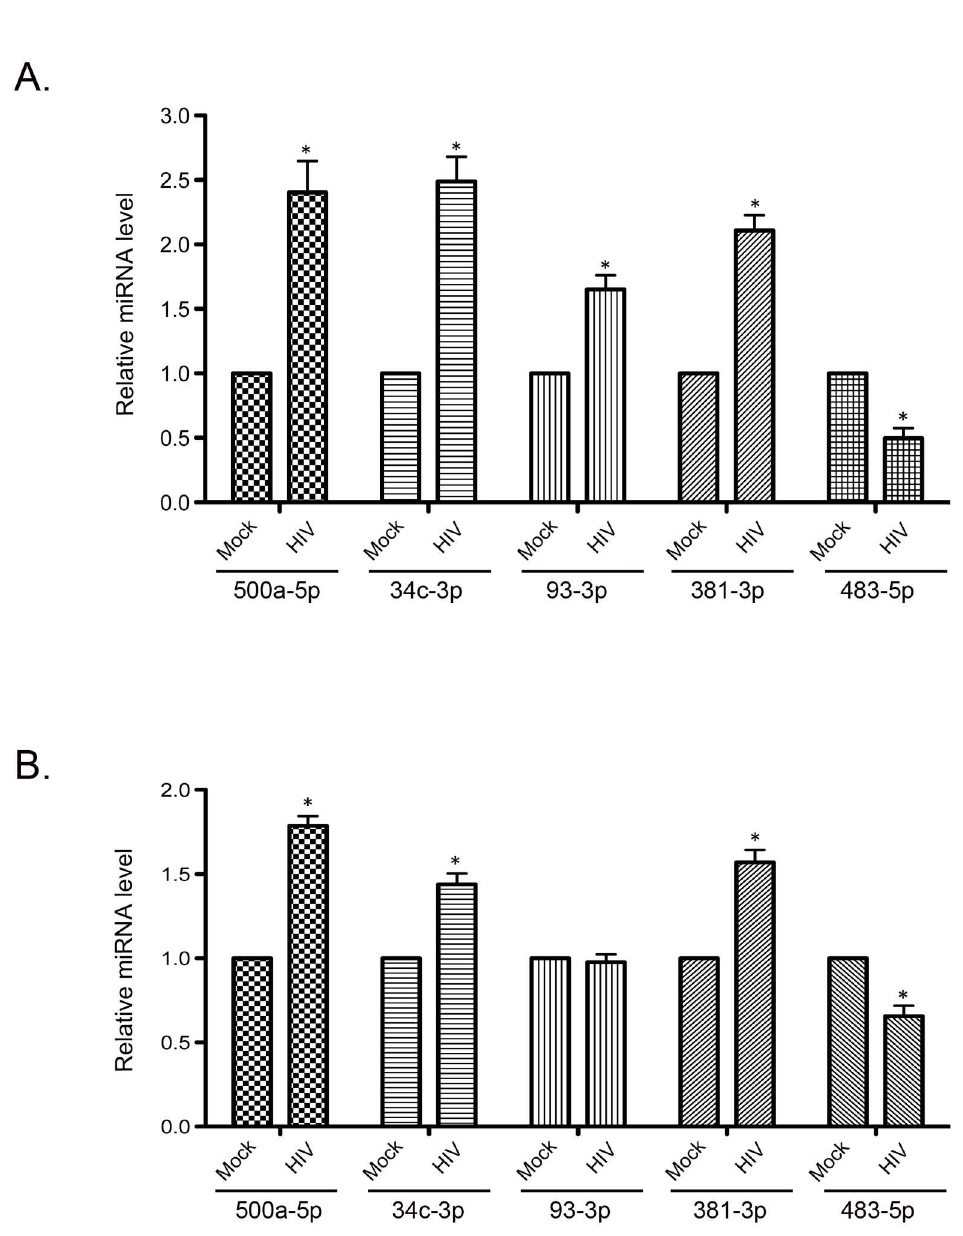
Fig 6. HIV-1 infection upregulates expression level of multiple miRNAs that target PEX mRNAs. A. Primary monocyte-derived macrophages (MDM) from 3 donorswere infected with HIV (pYu2, MOI = 2.0) for 5 days and relativelevels of miRNAs were determined by RT-PCR from total RNA extracted from the samples. The averagerelativelevels of miRNAs (normalized to snRNU6)from 3 independent experiments were determined.Error bars represent standarderror of the mean. B. Hela CD4+ cells were infected with HIV-1 (pYu2, MOI = 10.0) for 48 hours and relative levels of miRNAs were determined as describedin panel A. N = 3. Error bars represent standard error of the mean. * p <